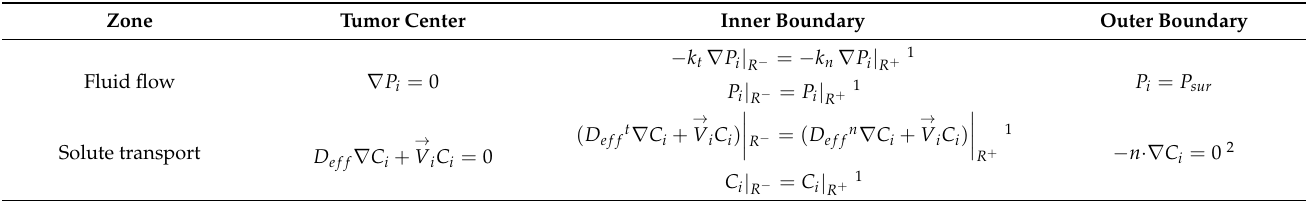
Table 2. BCs of fluid flow and solute transport